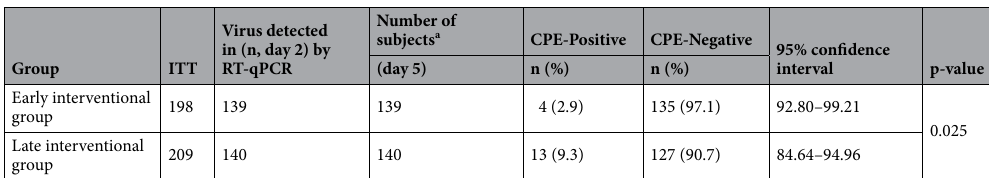
Table 4. SARS-CoV-2 viral infectivity rate on day 5 compared to RT-qPCR positives on day 2. a Subjects who tested positive for COVID-19 on day 2 and were retested on day 5 were included in the study.